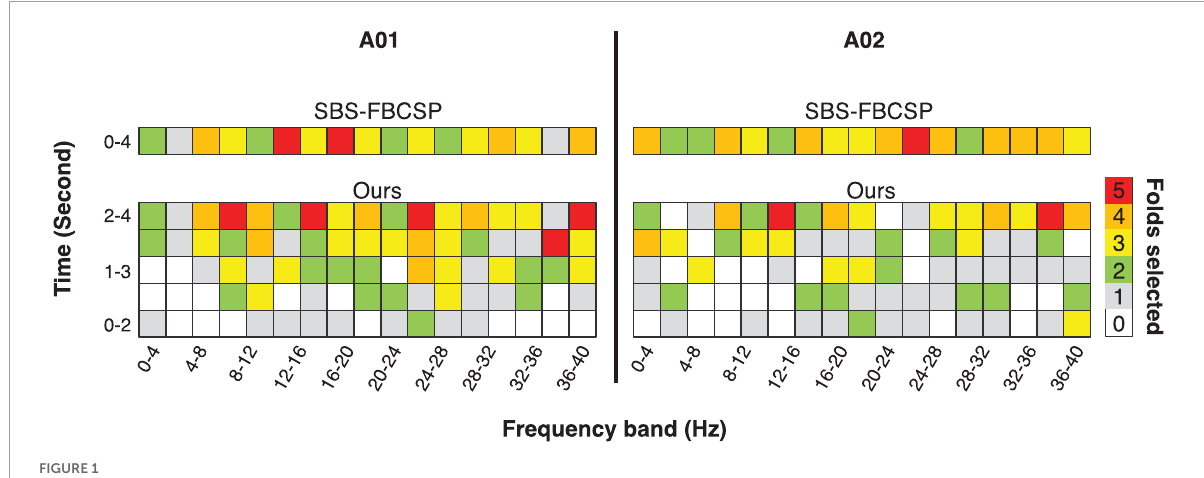
FIGURE1 Illustration of the results of the 5-fold feature selection comparing a contender algorithm (SBS-FBCSP) and our algorithm, which namely differ in the breakdown of temporal features. The colors (taken from subject A01, A02; chosen arbitrarily) denote the number of times a feature-subset was selected during the 5-fold cross